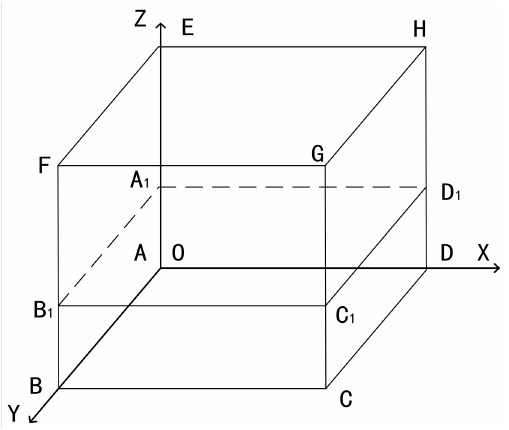
Figure 7. Spatial division of airspace